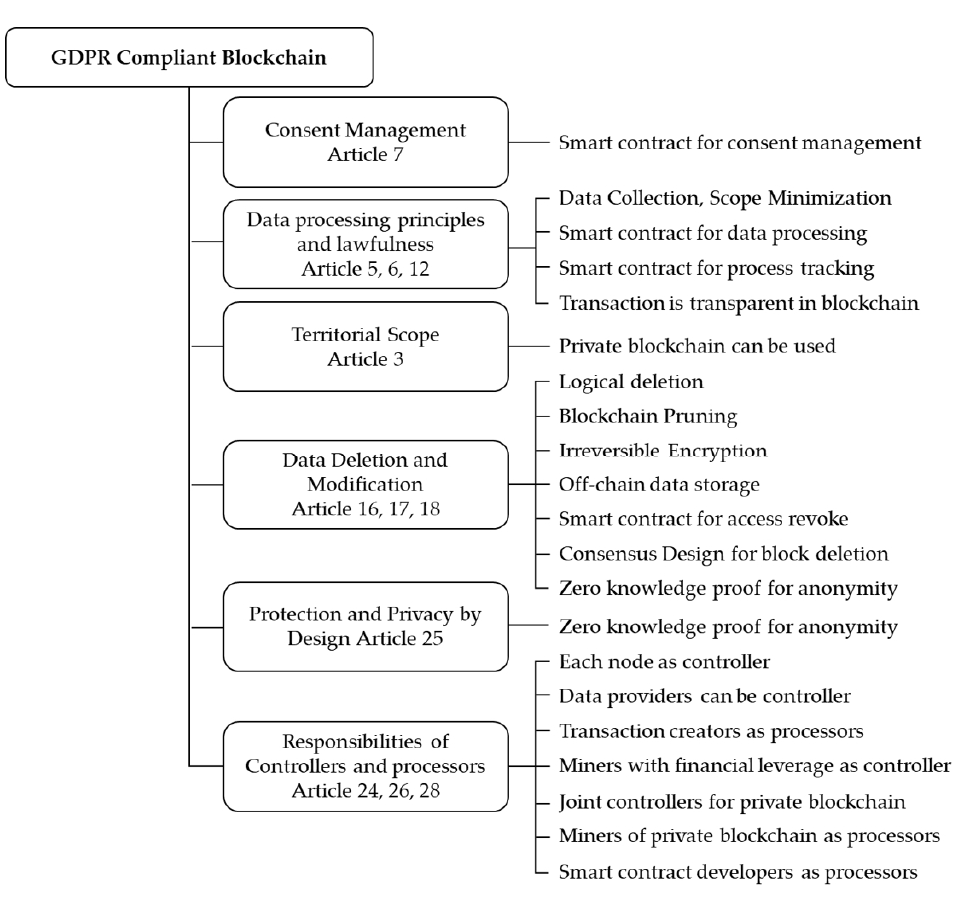
Table 3. The limitations of related works for GDPR compliance audits.